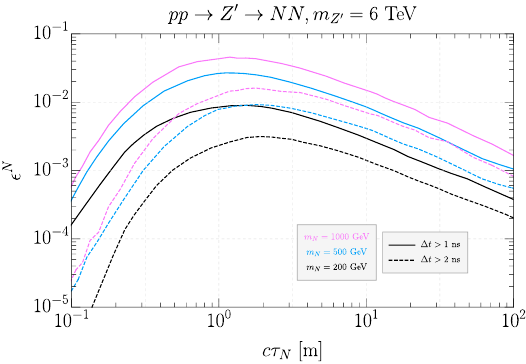
Figure 10 . The acceptance rate (cid:15) N as a function of cτ N , for three values of m N .